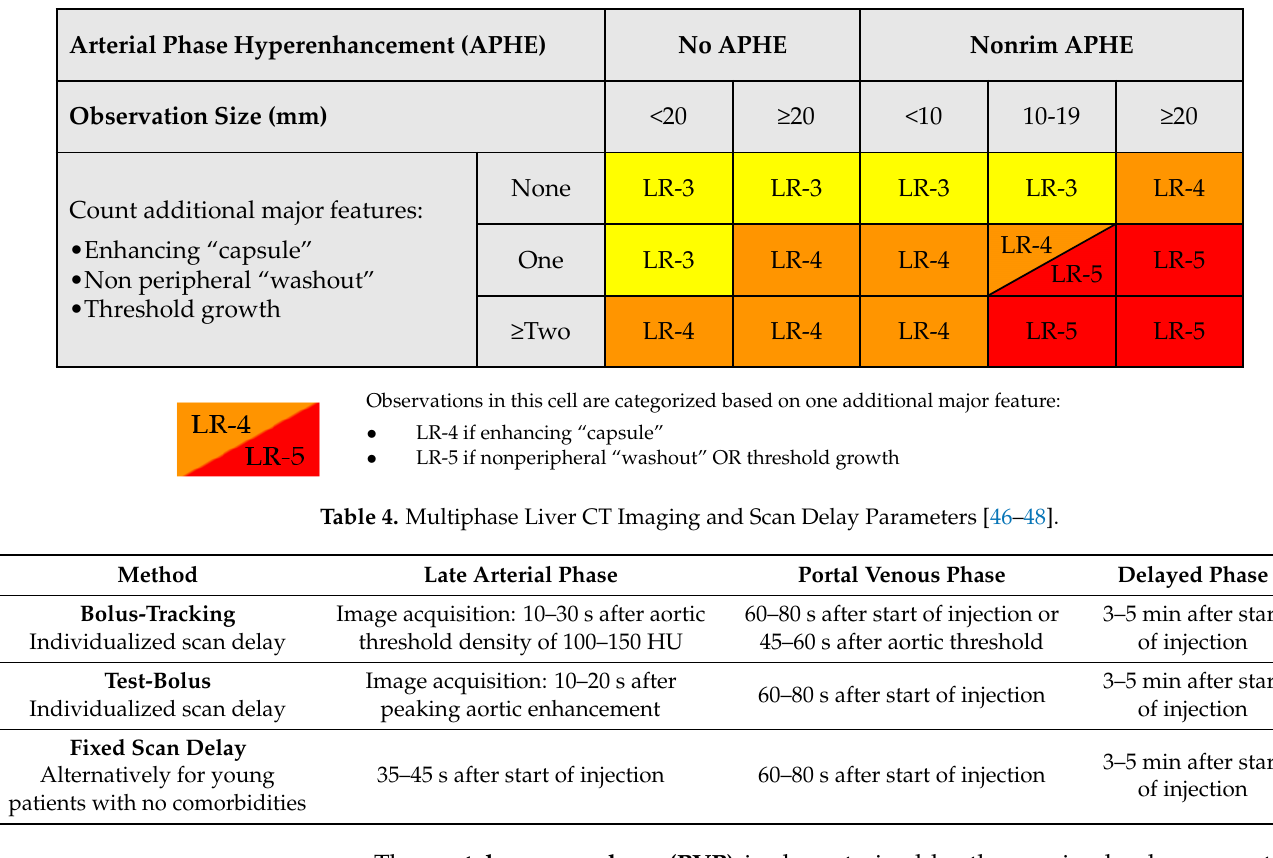
Table 4. Multiphase Liver CT Imaging and Scan Delay Parameters [46 – 48] .